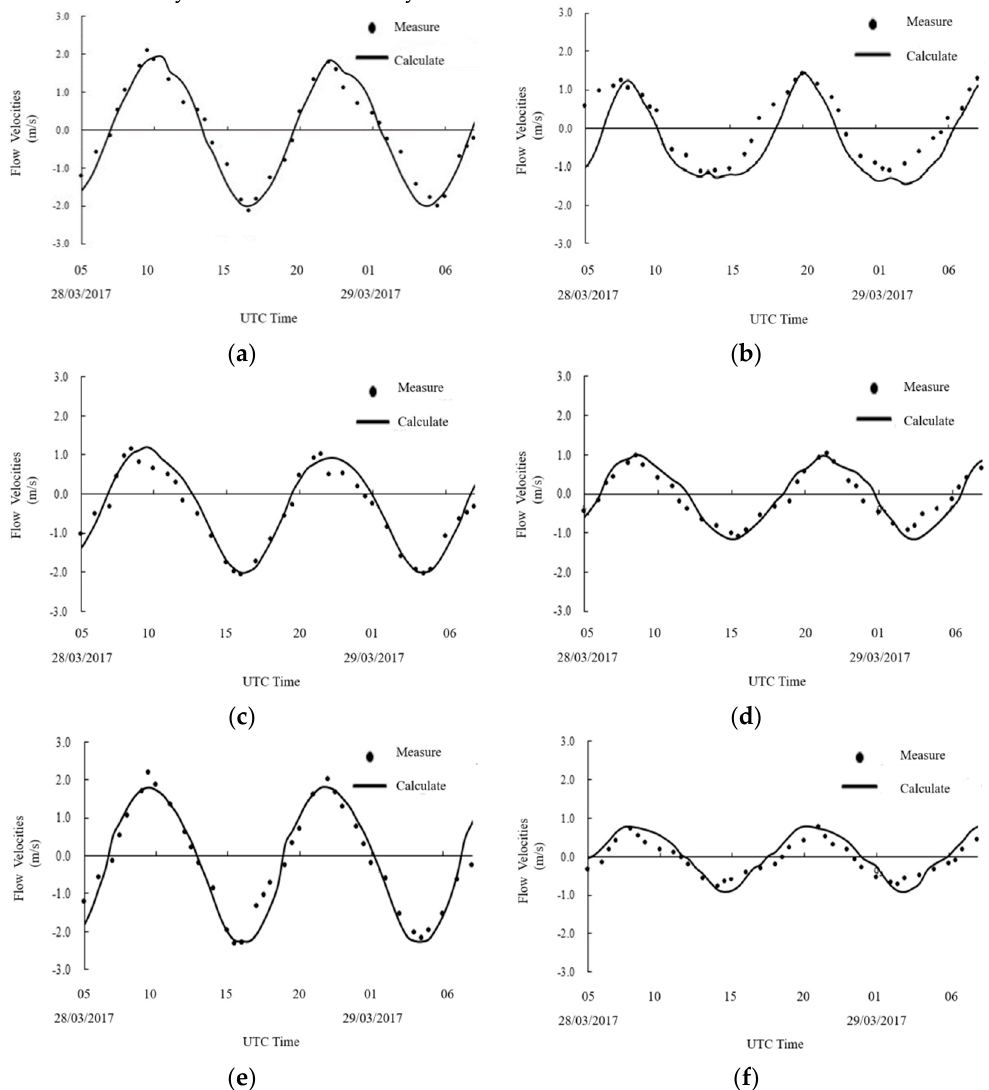
Figure 7. Modeled and measured flow velocity data at six stations. ( a ) SW1 station, ( b ) SW2 station, ( c ) SW3 station, ( d ) SW4 station, ( e ) SW5 station, ( f ) SW6